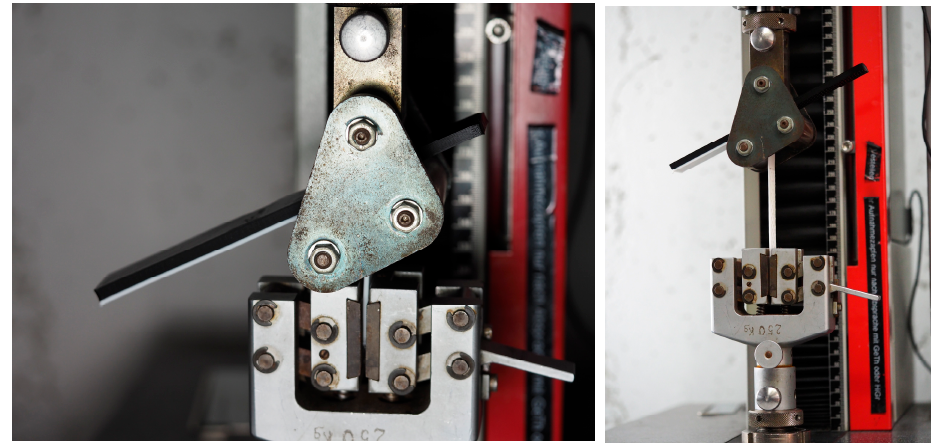
Figure 8. Depiction of roll peeling tests.